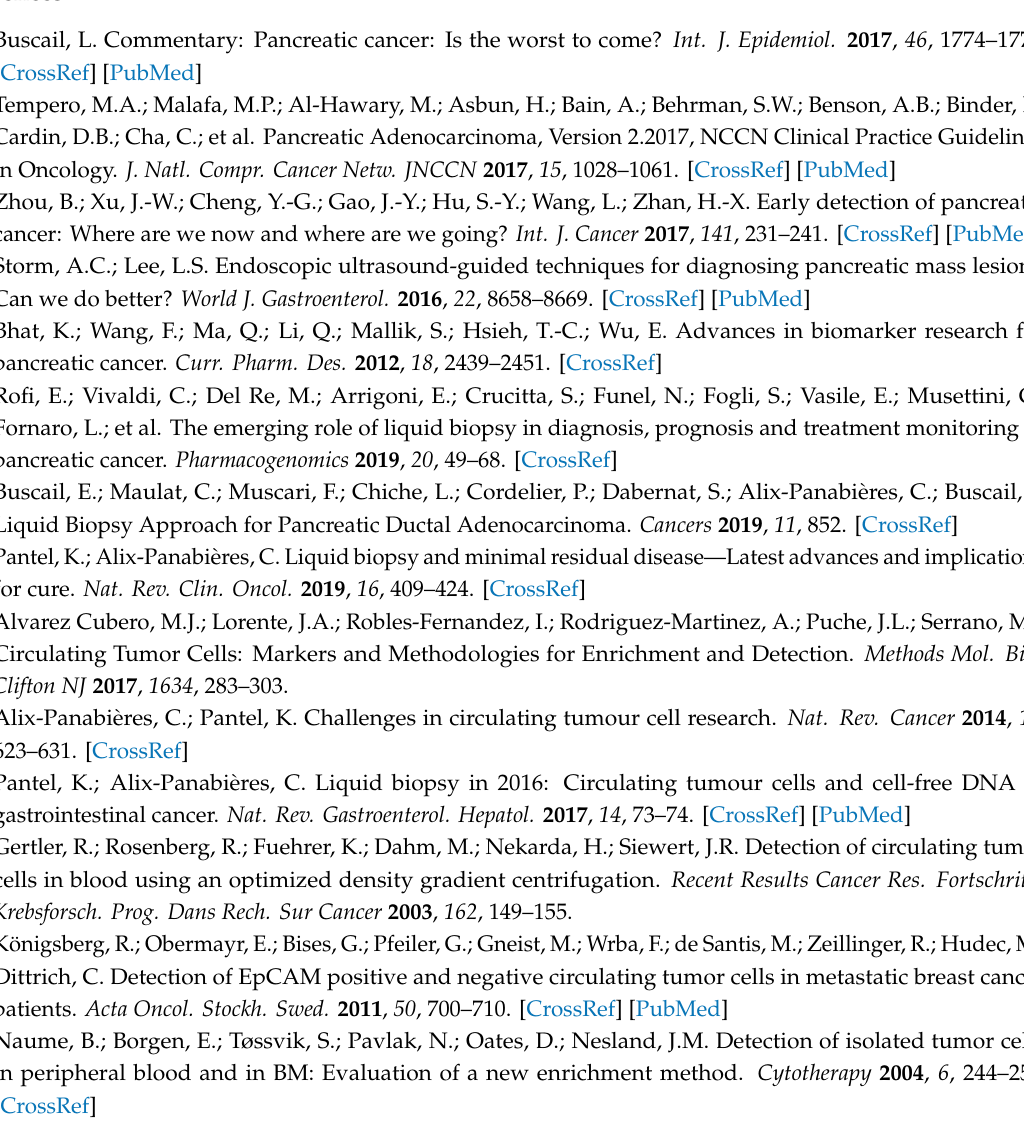
Table S1: Clinical features of the cohort, Figure S1: Tumor cell detection in cell spiking